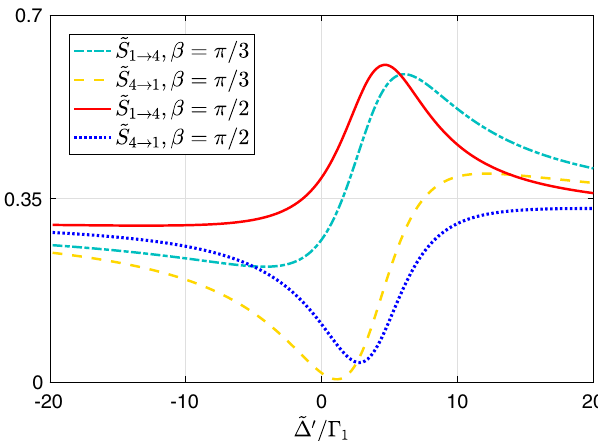
Fig. 9 Nonreciprocal scattering behaviors in a three-level Δ -type giant- atom system. Scattering probabilities versus the detuning ~ Δ 0 with different phases of the external coherent fi led β . Other parameters: atomic dissipation rates γ ¼ γ ¼ 0, the ratio of two atomic emission rates into e 1 e 2 different waveguides Γ 2 / Γ 1 = 1, Rabi frequency of the external coherent fi eld ε = 30 Γ 1 , and accumulated phases of the photon traveling in waveguides W a and W b ϕ a 0 = ϕ b 0 = π